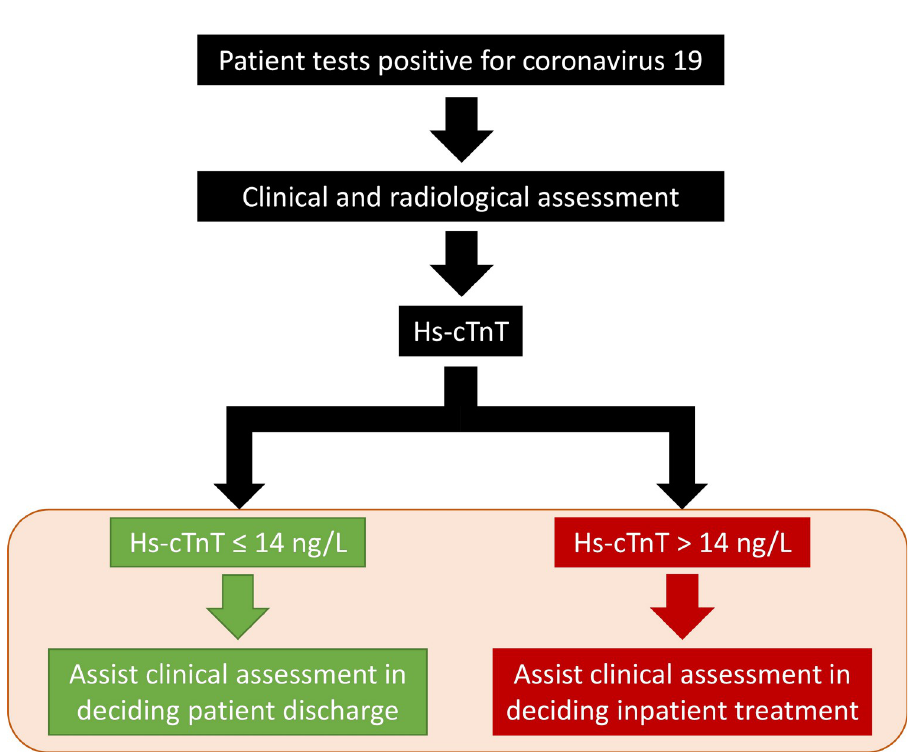
Fig 4. Future directions. Whether hs-cTnT can be used to assist clinical assessment to decide on patient discharge or inpatient treatment requires further investigation, as denoted by the orange panel. Hs-cTnT: High sensitivity cardiac troponin